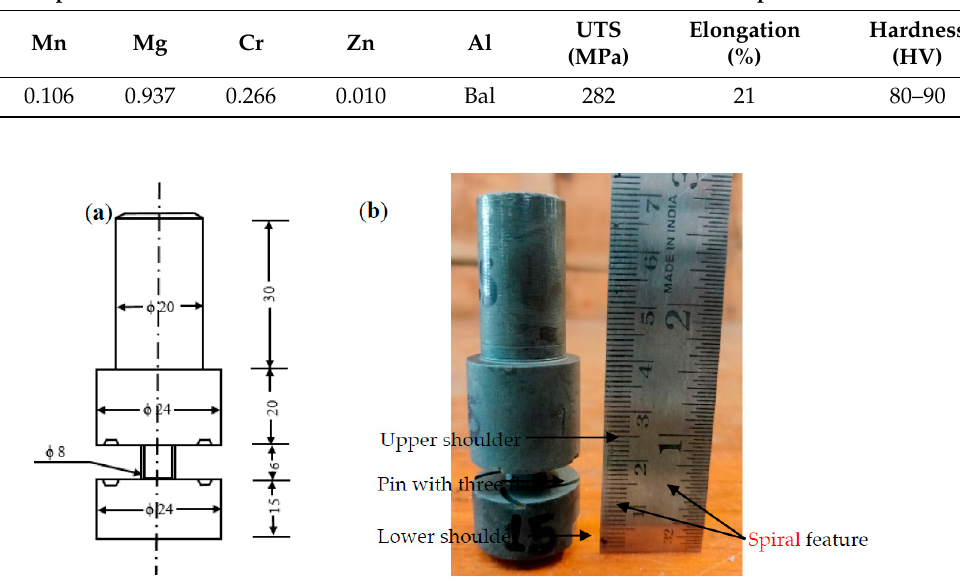
Figure 1. Bobbin tool used during experiments ( a ) Schematic of tool ( b ) Manufactured tool.